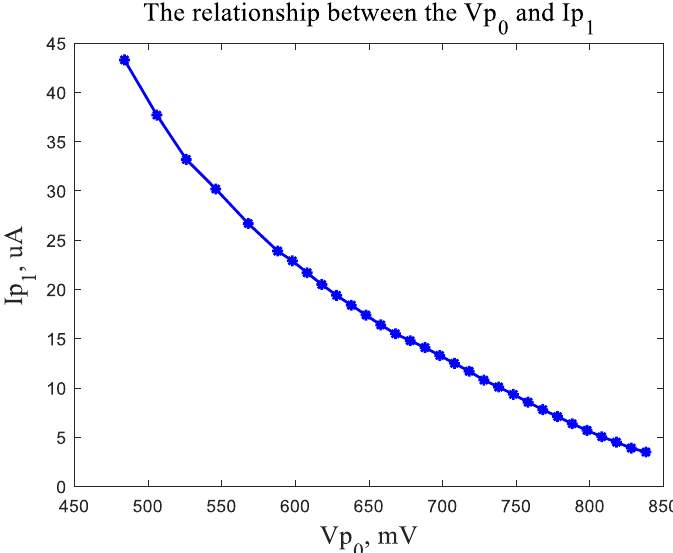
Figure 12. The relationship between the Vp 0 and Ip 1 .